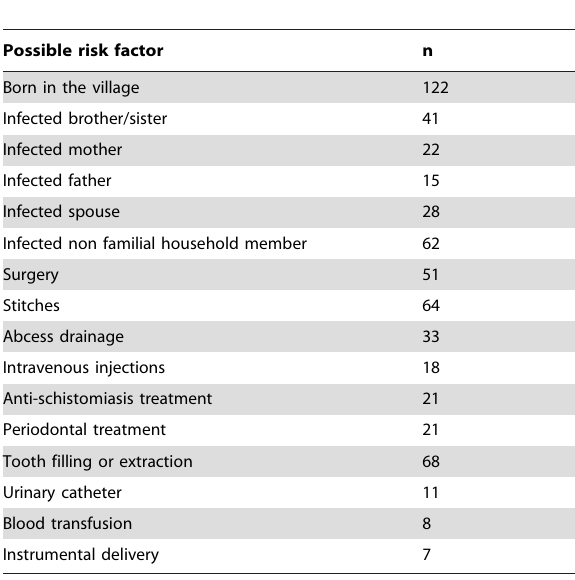
Table 1. Number of participants exposed to each risk